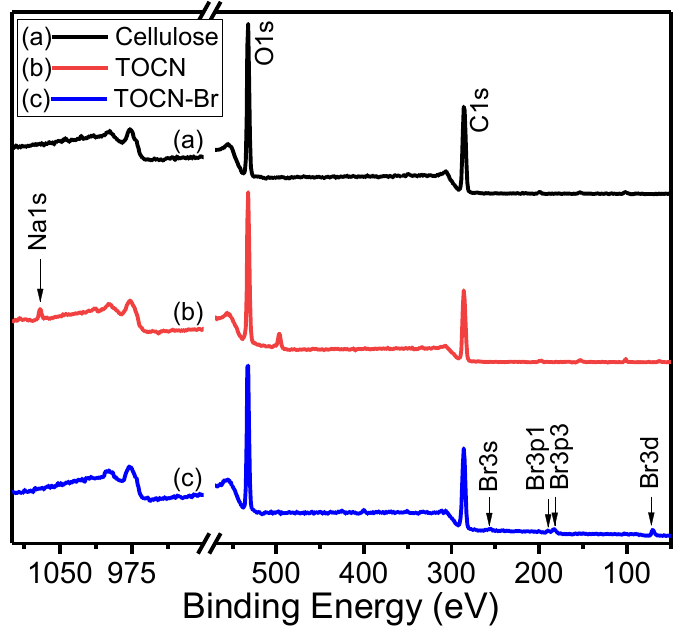
Figure 2. Electron spectroscopy for chemical analysis (ESCA) adsorption spectra ( a ) pristine cellulose, ( b ) TEMPO-oxidized cellulose nanofibers (TOCN), and ( c ) TOCN – Br.